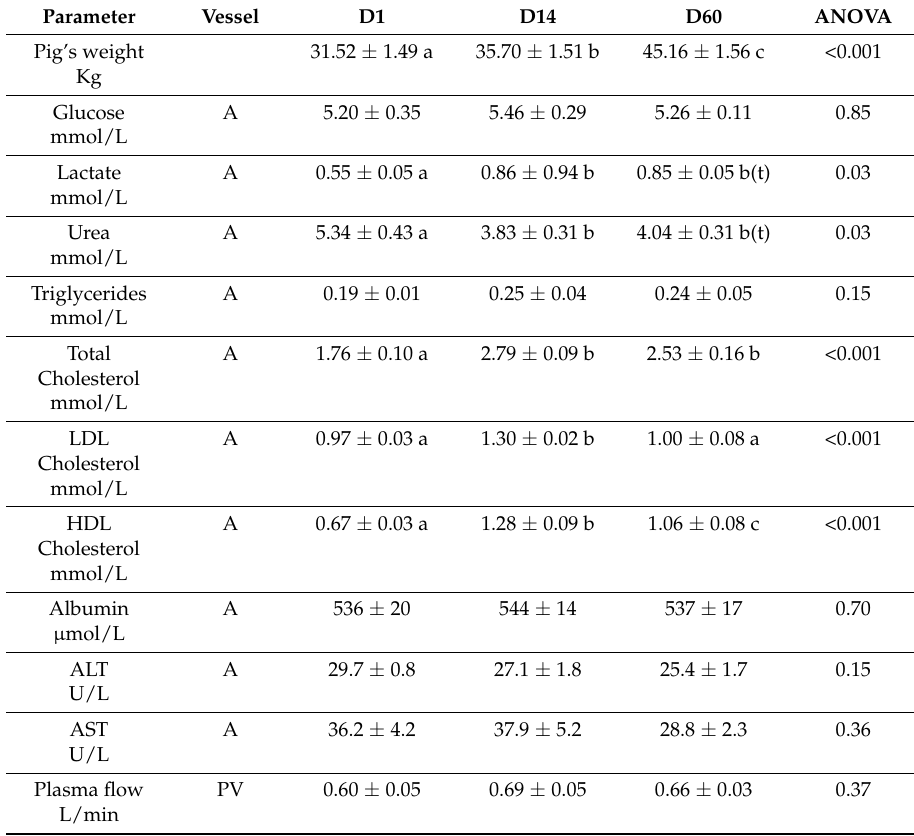
Table 1. Animals’ weight, arterial concentration in the fasted state of glucose, lactate, urea, triglycerides, total cholesterol, Low Density Lipoprotein (LDL)-cholesterol, High Density Lipoprotein (HDL)-cholesterol, albumin, alanine aminotransferase (ALT), aspartate aminotransferase (AST) before (D1) and after 14 days (D14) and 60 days (D60) of adaptation to High Fat High Sugar (HFHS) diet. Average plasma flow in portal vein (PV), hepatic vein (HV), and hepatic artery (HA) from 0 to 8.5 h post meal ingestion before (D1) and after 14 days (D14) and 60 days (D60) of adaptation to HFHS